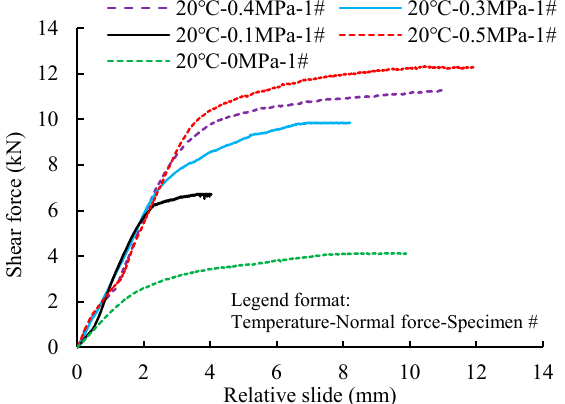
Figure 9. Shear force-relative slide relationship with separator layer.